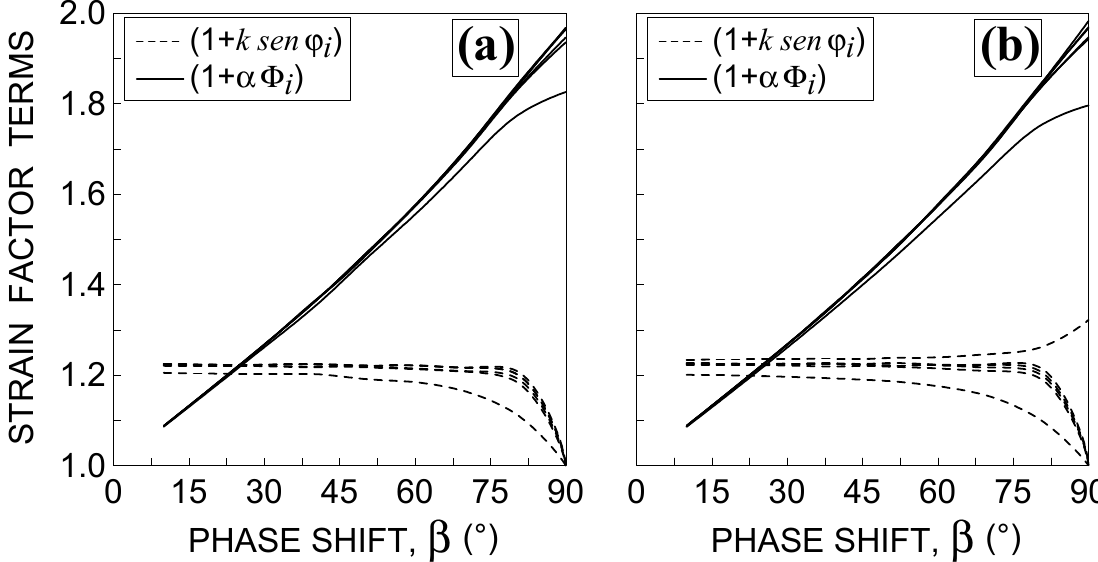
Figure 6. Influence of the phase shift β ( 10 ◦ ≤ β ≤ 90 ◦ ) on both terms of the strain factor f i proposed by Borodii et al. [3–5] for the non-proportional loading conditions: ( a ) Nos. 7–12 and ( b ) Nos. 13–18, in Table 2.